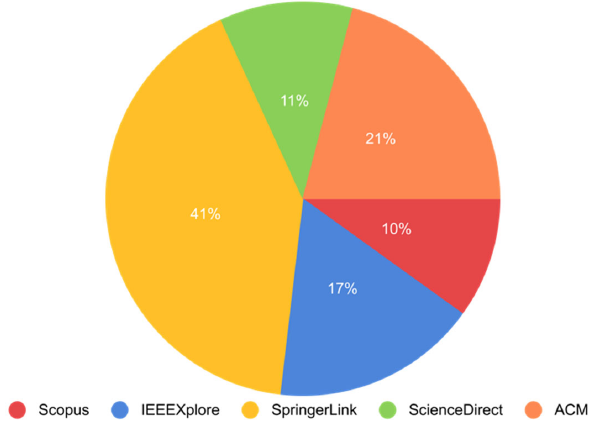
Figure 10. Percentage of articles found in each database searched .